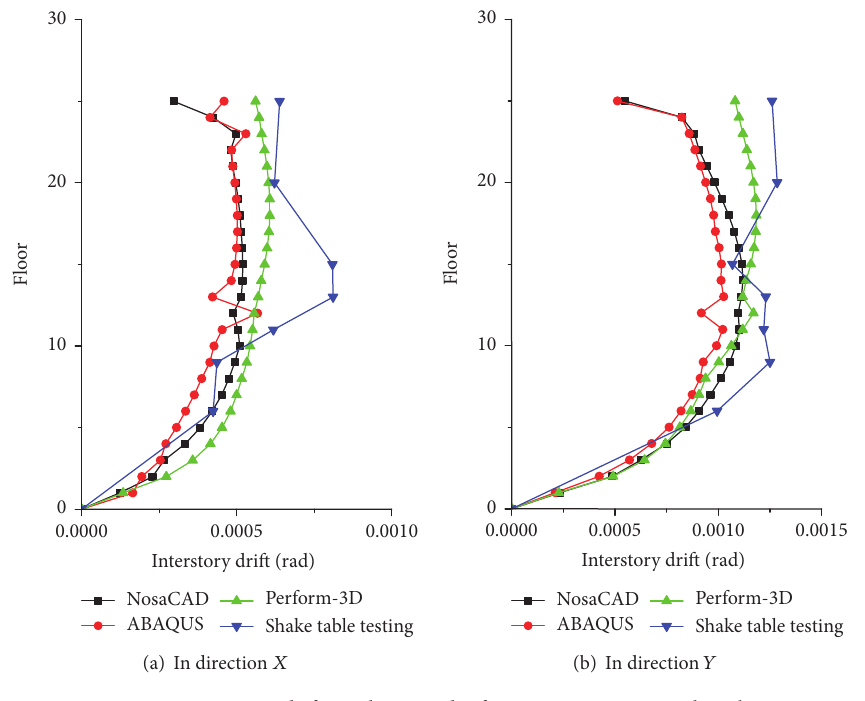
Figure 19: Interstory drift envelopes under frequent intensity 7 earthquakes.